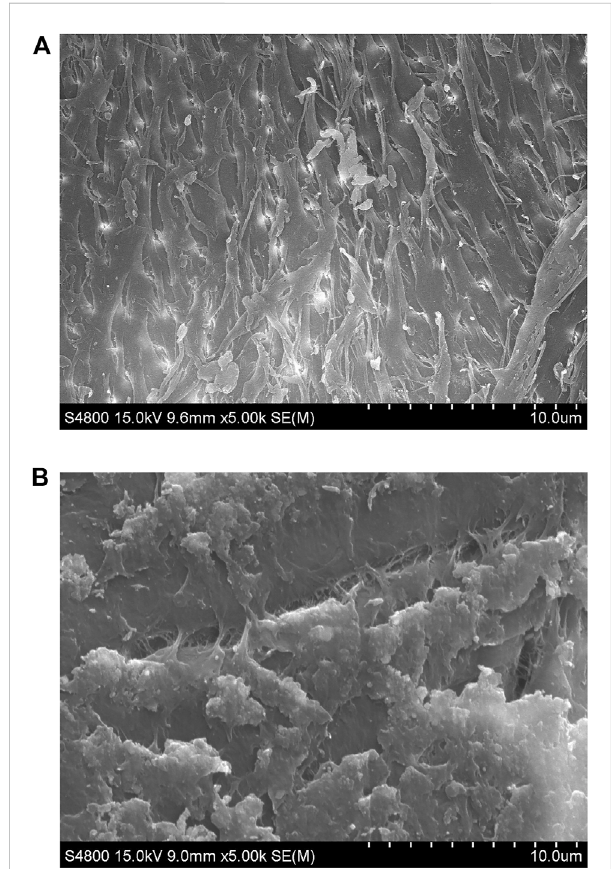
FIGURE 4 SEM of chitin and chitosan surface structures at ×1,000 magni fi cation. (A) Untreated chitin. (B) The treated chitin after cultivation with B. cereus ZWT-08 for 48 h, which has been deacetylated to